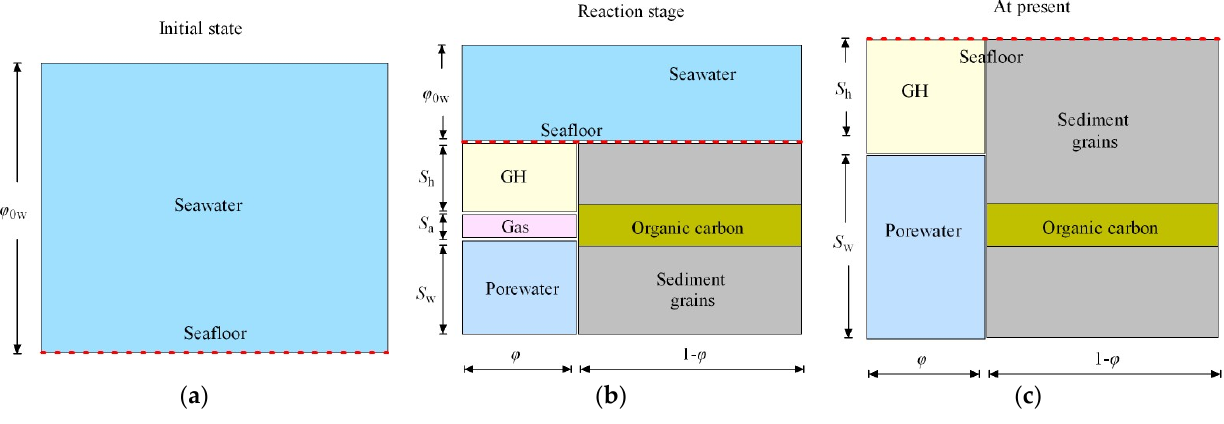
Figure 1. Schematic illustration showing how stratigraphic-diffusive GHs are generated during the deposition process within the slope surface seabed. At the start, the research area above the designated slope baseline is fully occupied by seawater, and there are no sediments, which means the initial porosity φ 0w is 100%. In this work, φ 0w was specifically set as 0 in order to create a strong contrast effect with the status when the sediments were accumulating ( a ). With constant deposition, sinking debris piles up to form seafloor sediments. It is composed of sediment grains (1 − φ ), and pore space ( φ ), which ordinarily contains different saturated pore waters ( S w , including dissolved gas), GH ( S h ) produced by organic carbons, and free gas ( S a ) ( b ). In the end, the initial seawater is replaced by sediments. Gas in the pores is depleted and GH accumulates to create reservoirs ( c